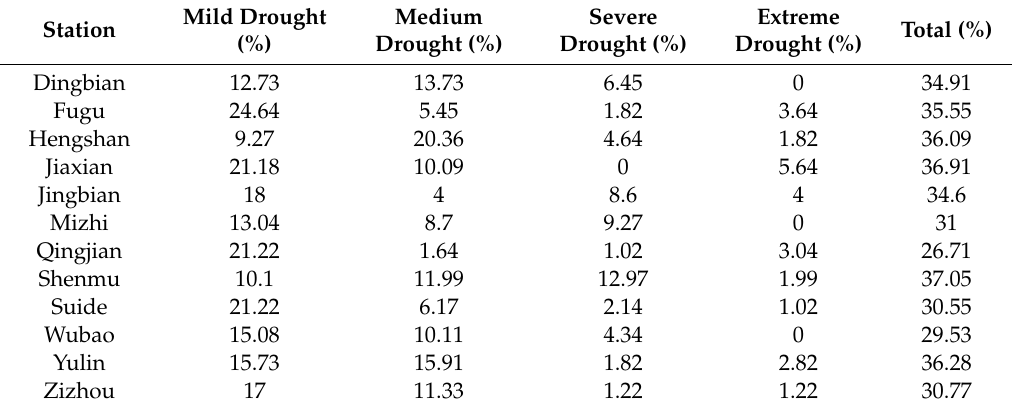
Table 1. Occurrence frequency of di ff erent grades of annual drought in Yulin